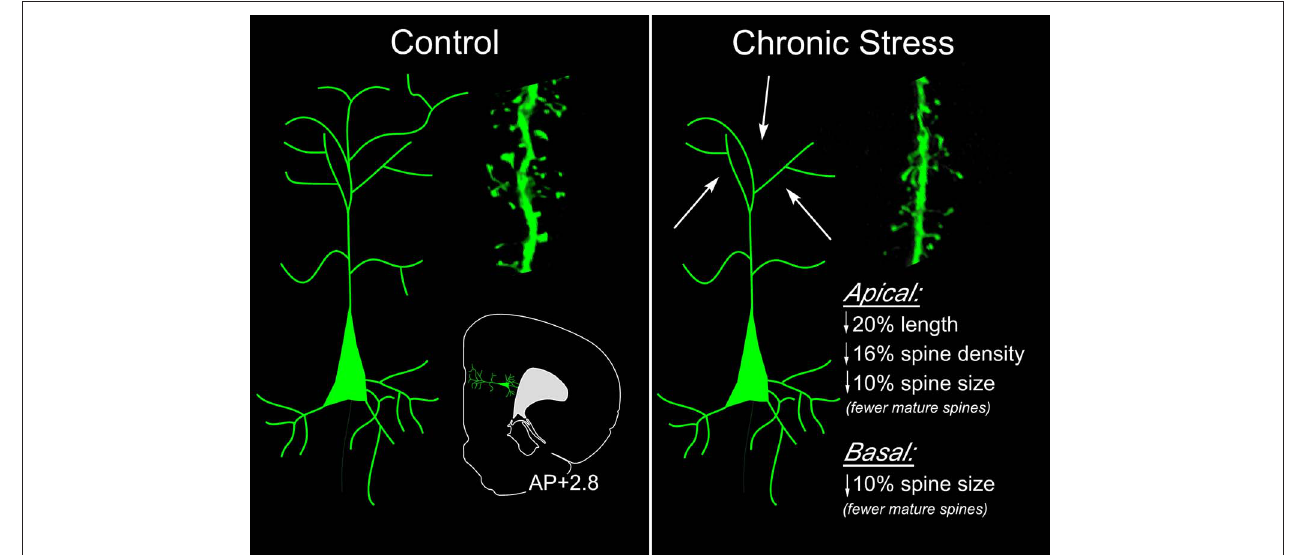
for morphologic analyses. Distance in millimeters relative to bregma is indicated. Arrows highlight the fact that dendritic atrophy and spine/excitatory synapse loss is most prominent on distal apical dendrites (right). Spine morphologic analyses reveal fewer spines with mature (stubby, mushroom-shaped), and a greater number with immature (long and thin)